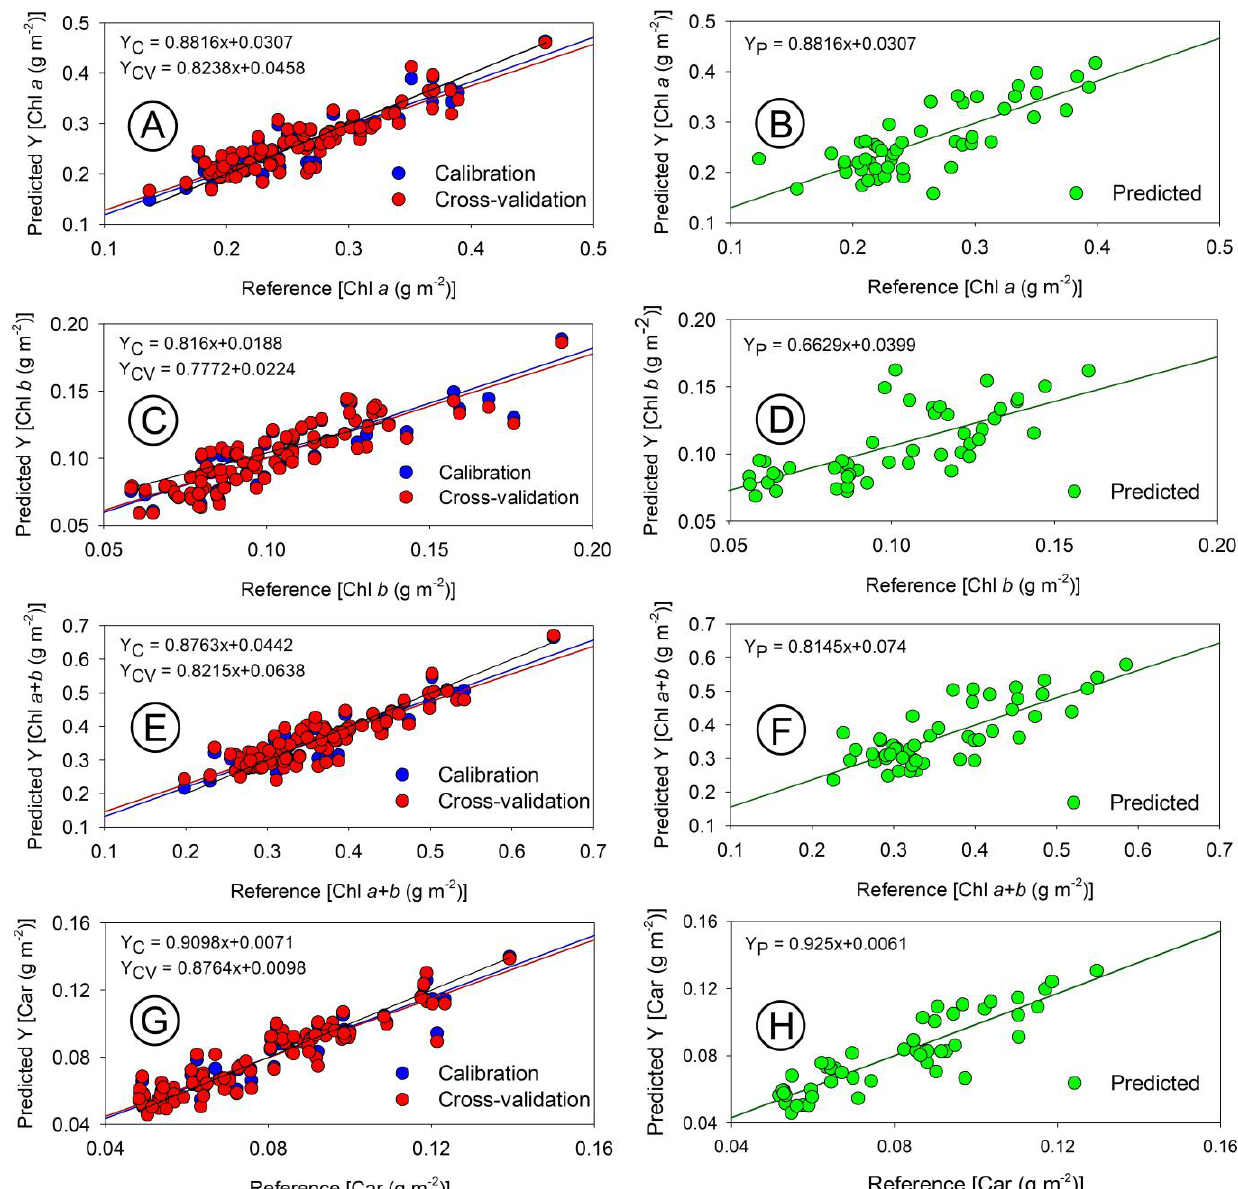
Figure 12. Scatterplot of models based on absorbance curves (400 – 700 nm) obtained with the spectroradiometer. ( A , B ) chlorophyll a (Chl a ). ( C , D ) chlorophyll b (Chl b ). ( E , F ) chlorophyll total (Chl a + b ). ( G , H ) carotenoids (Car). Linear equation estimates were reported for calibration (Y C ; blue dots), cross-validation (Y CV ; red dots), and predicted (Y P ; green dots).